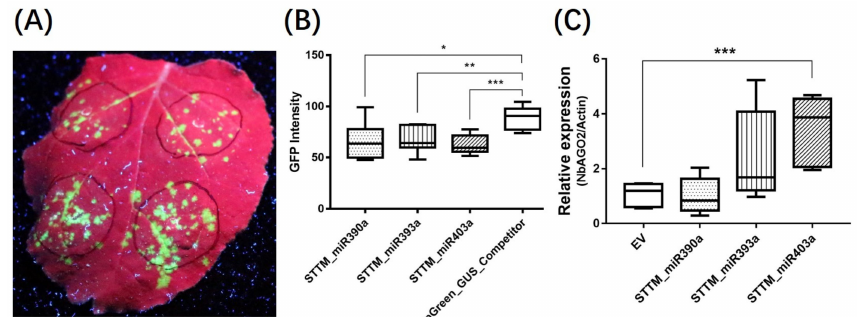
Figure 7. STTM_miR403a suppressed TMV infection. ( A ) N. benthamiana plants were